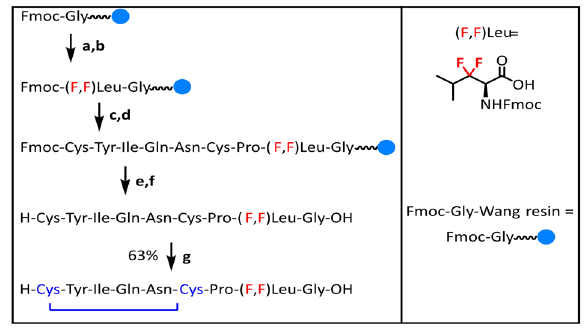
Fig. 8 Solid-phase peptide synthesis of di fl uorinated oxytocin. a About 20% piperidine/DMF, 10 min, double; b 1.5 equiv. fl uorinated leucine, 1.5 equiv. HOBt, 1.5 equiv. DIC, minimum DMF, rt, 16 h; c 10% piperidine/DMF, 3 mins, double; d 3 equiv. amino acid, 2.9 equiv. HBTU, 6 equiv. DIPEA, minimum DMF, rt, 1.5 h; e 10% piperidine/DMF, 3 mins, double; f TFA cocktail, global deprotection, rt, 3 h; g GSH/GSSG folding, rt, over-night. Fmoc = fl uorenylmethoxycarbonyl, HOBt = hydroxybenzotriazole, DIC = N,N ’ -diisopropylcarbodiimide, HBTU = N,N,N ’ ,N ’ -tetramethyl- O-(1H-benzotriazol-1-yl)-uronium hexa fl uorophosphate, DIPEA = N,N - diisopropylethylamine, GSSG = glutathione disul fi